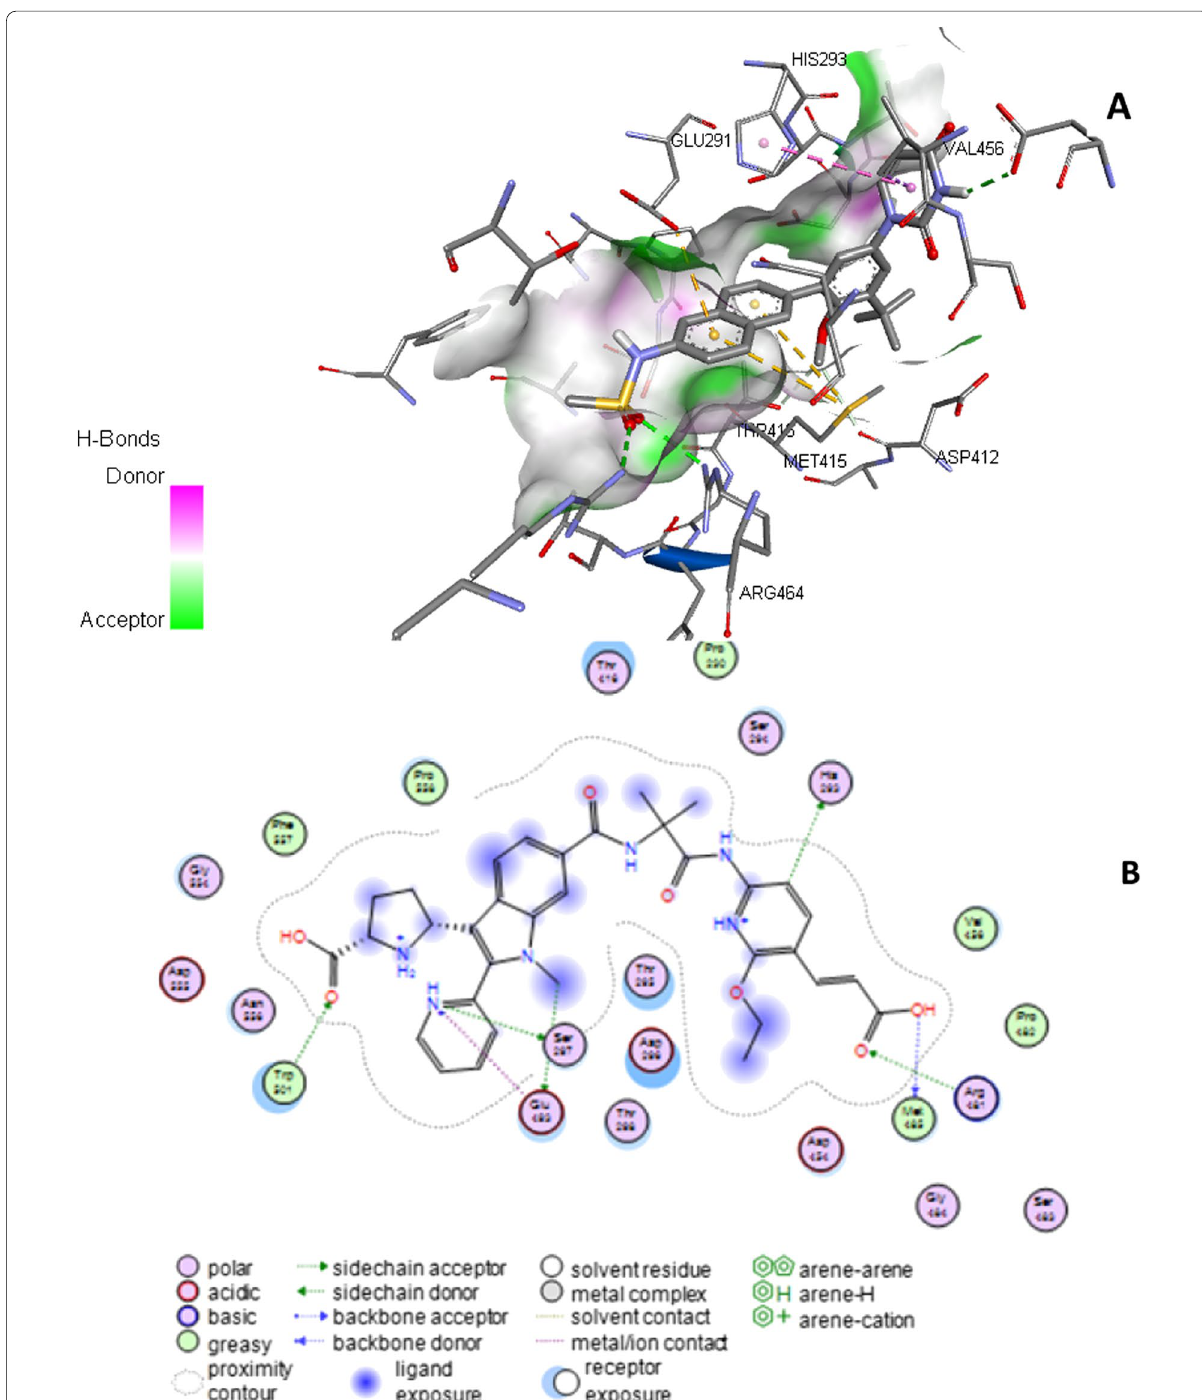
Fig. 5 A 3D diagram for the interaction of molecule 15 (N15) in complex with the target receptor (hepatitis C virus NS5B RNA polymerase, PDB ID: 4MKA), B 2D diagram for the interaction of molecule 15 (N15) in complex with the target receptor (hepatitis C virus NS5B RNA